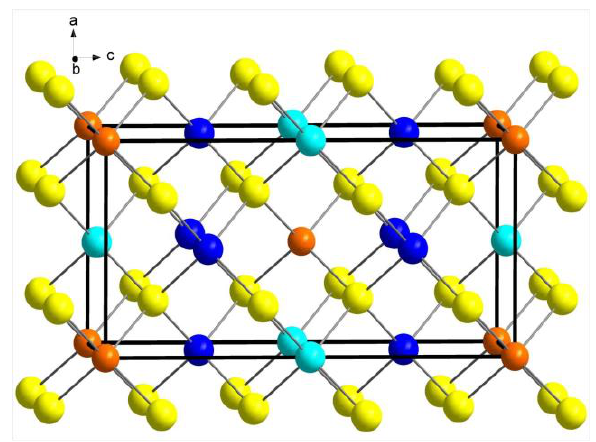
Figure 3. The crystal structure of richardsite. Cu, Zn, Ga, and S atoms are given as light blue, dark blue, orange, and yellow circles, respectively. The unit cell of the structure is outlined in black, and its orientation is indicated at the top left.